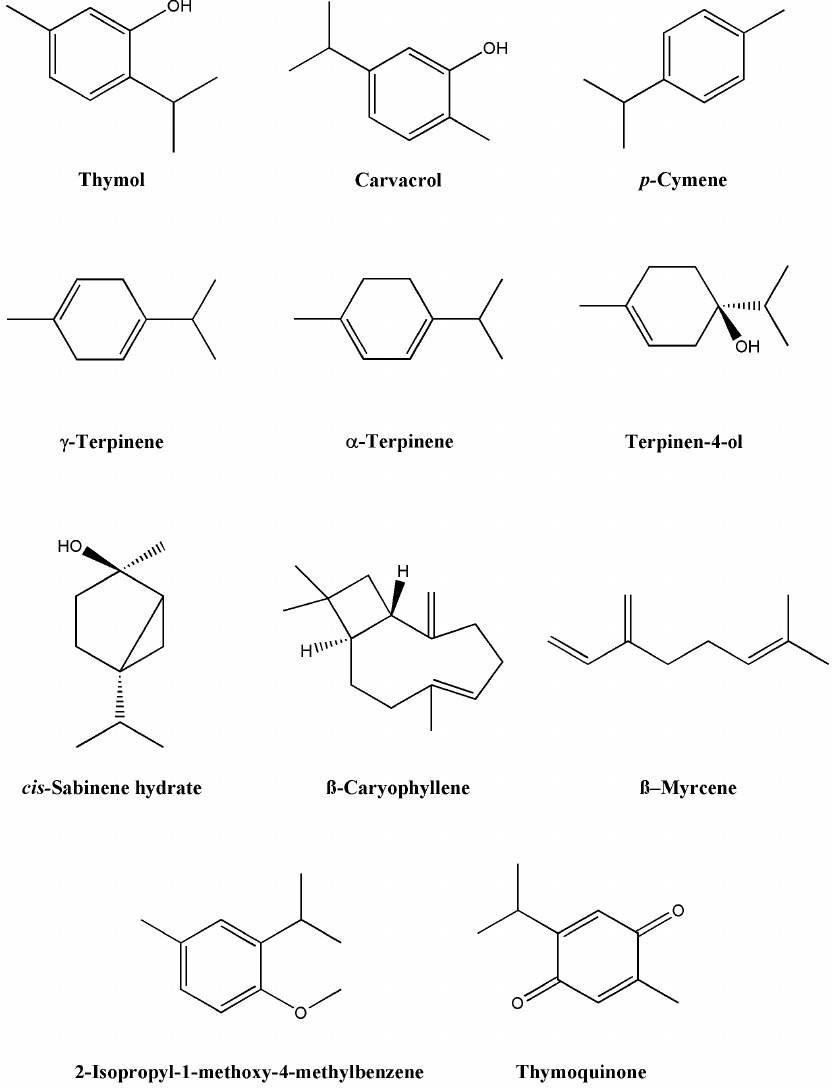
Figure 2. Major phytochemical components of Origanum syriacum essential oil. Table 2. Summary of the essential-oil composition and the volatiles profile from different parts of Origanum syriacum plants from different areas.